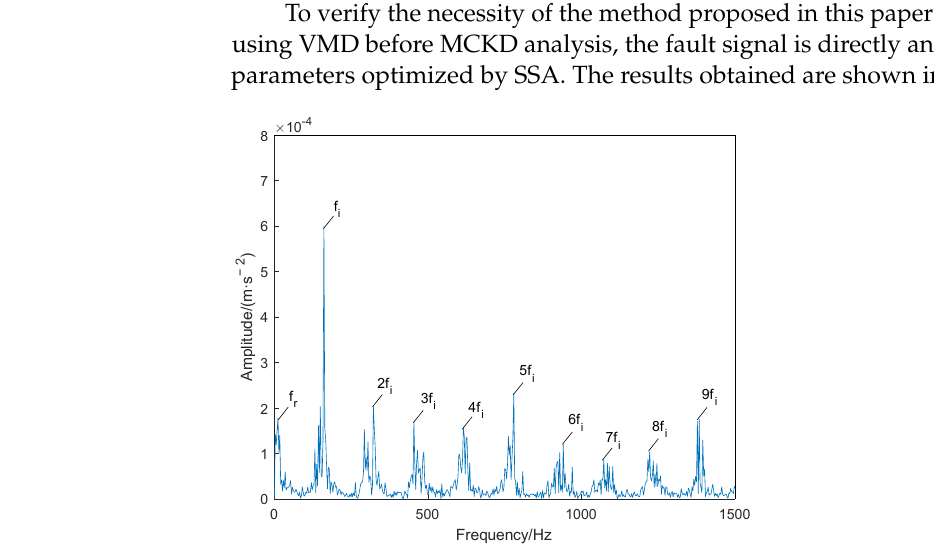
Figure 19. Time-domain waveform and envelope spectrum after MCKD processing: ( a ) time-domain graph after MCKD processing; ( b ) envelope spectrum after MCKD processing.